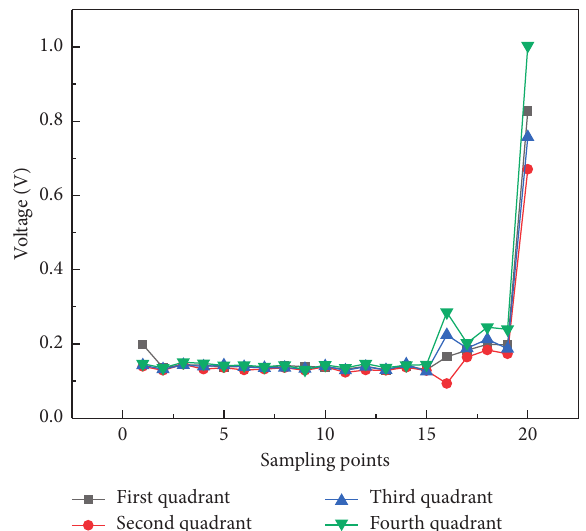
Figure 6: The voltage value of each quadrant after the capture is completed.